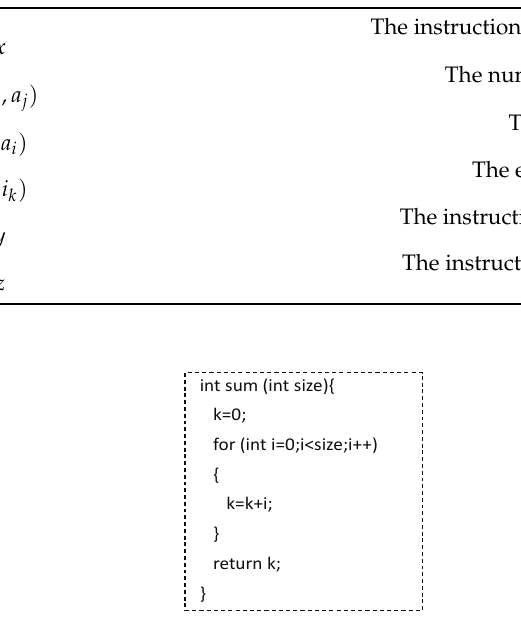
Figure 3. A program code.